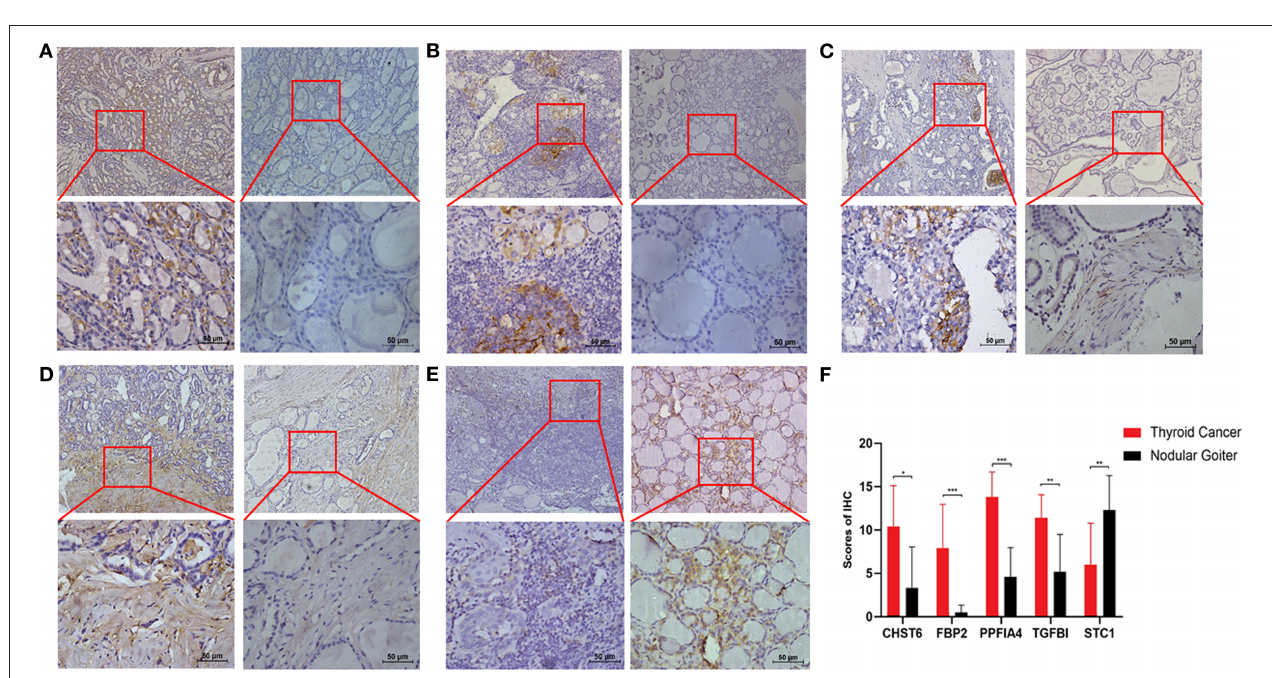
FIGURE 7 | Measurement of glycolysis-related genes at protein levels in clinical samples. Representative immunohistochemical staining images of (A) CHST6, (B) FBP2, (C) PPFIA4, (D) TGFBI, and (E) STC1 in human thyroid cancer sections (left line) and nodular goiter sections (right line). (F) Protein expression scores in human thyroid cancer sections and nodular goiter sections. * p < 0.05, ** p < 0.01, and *** p < 0.001.